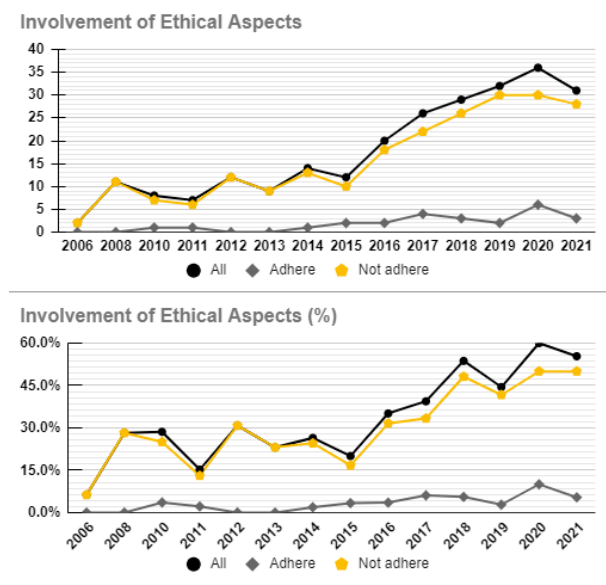
Figure 2. Involvement of ethical